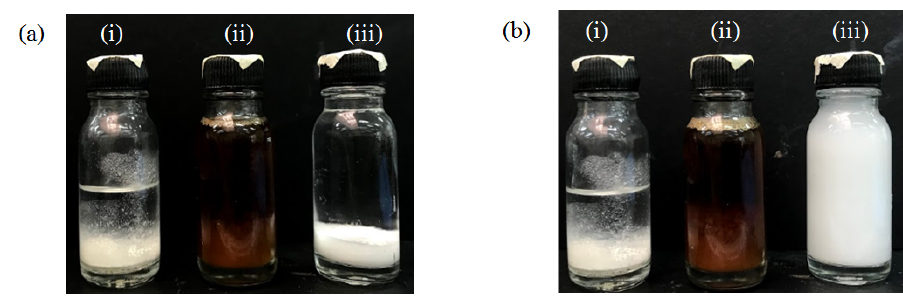
Figure 2. Images of ( i ) hexane-added solution, ( ii ) acetone-added solution and ( iii ) isopropanol- added solution ( a ) before and ( b ) after they were shaken.